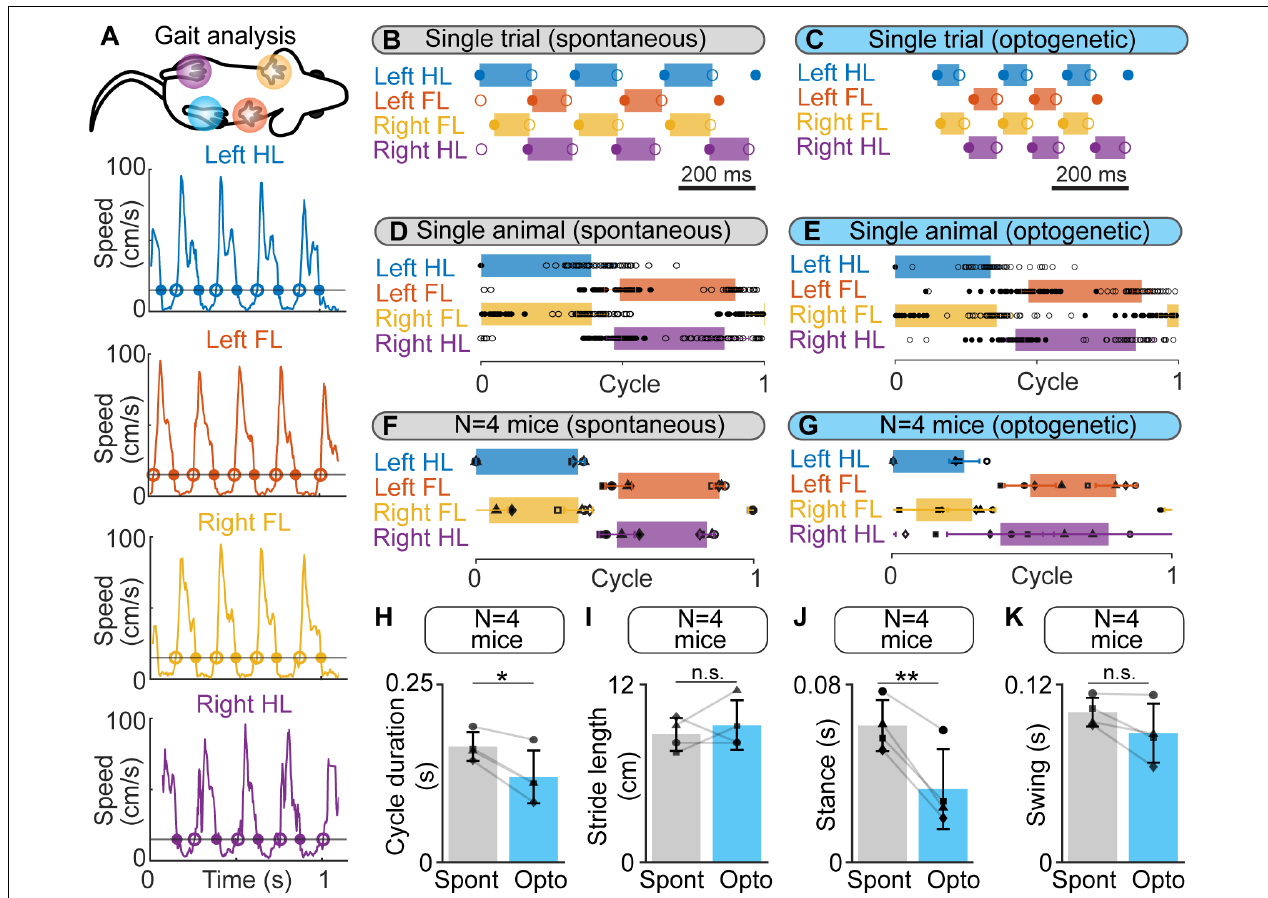
FIGURE 3 | Gait diagrams during spontaneous locomotion and locomotion evoked by optogenetic stimulation of the cuneiform nucleus (CnF) in Vglut2-ChR2-EYFP mice in a linear corridor. (A) Mouse forelimbs (FL) and hindlimbs (HL) were filmed from below at 300 fps in a transparent linear corridor and the position of each limb was tracked frame by frame with DeepLabCut (see “Materials and Methods” section). The four panels show the movement speed of each paw as a function of time. Cycle duration was defined as the time duration between two touchdowns of the left hindlimb (HL) using a speed threshold of 15 cm/s to define the transitions between swing and stance phases. Full circles are touchdowns; empty circles are lift-offs. (B,C) Gait diagram for each limb obtained during a single spontaneous locomotor bout (B) and a locomotor bout evoked by optogenetic stimulation in the same animal (470 nm laser, 10 s train, 20 Hz, 10 ms pulses, 8% of laser power). Stance phase duration was drawn with a rectangle only when both touchdown and lift-off were present in the recording. (D,E) Gait diagrams during a normalized locomotor cycle, showing the stance phase start (mean ± SD) and end (mean ± SD) during 16 spontaneous locomotor bouts (45 steps) and during 8 locomotor bouts evoked by optogenetic stimulation in the same animal (48 steps, same stimulation parameters as in E ). The cycle has been normalized to the left HL’s touchdown. (F,G) Normalized gait diagram showing the touchdown (mean ± SD) and lift-off (mean ± SD) pooled from four mice during a total of 55 spontaneous locomotor bouts (8–16 trials per animal, 13–45 steps per animal) and from four mice during a total of 30 locomotor bouts (6–8 bouts per animal, 8–48 steps per animal) evoked by CnF optogenetic stimulation (470 nm laser, 10 s train, 20 Hz, 10 ms pulses, 8–15% of laser power). The data from each animal are illustrated with a different symbol. (H–K) Comparison of cycle duration (H) stride length (I) stance duration (J) and swing duration (K) in four animals during spontaneous optogenetic-evoked locomotion (same animals as in F,G ). * P < 0.05, ** P < 0.01, n.s., not significant, P > 0.05, paired t